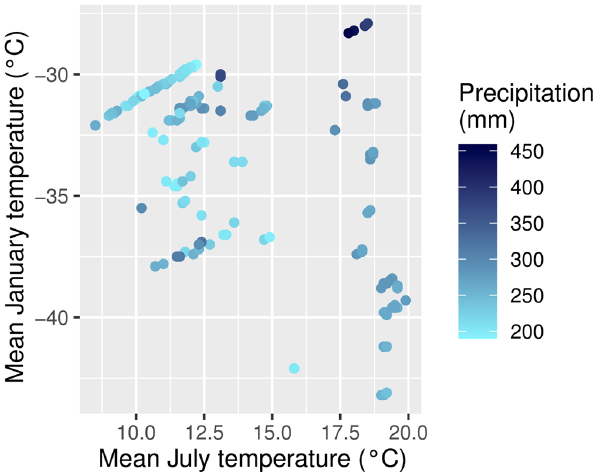
Figure 2. The climate on the plots according to CHELSA (Clima- tologies at high resolution for the Earth’s land surface areas) data. Mean January temperature is shown on the y axis, mean July tem- perature is shown on the x axis, and mean annual precipitation as coloured